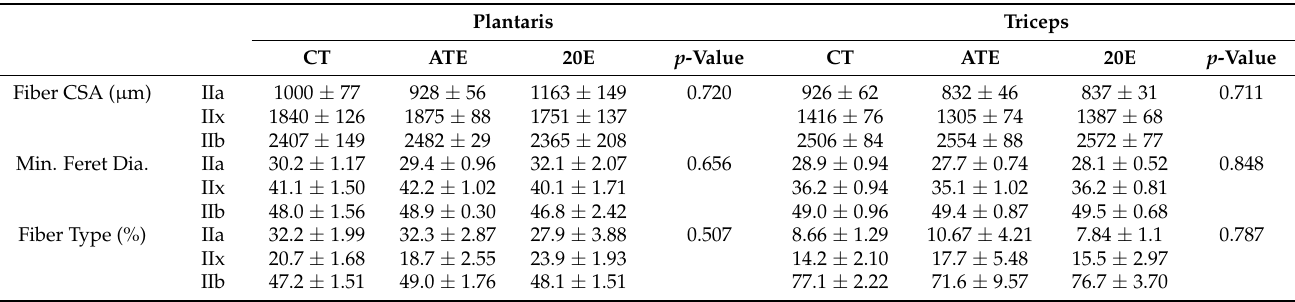
Figure 1. Immunohistochemical analysis of muscle fiber type. Representative images of fiber type and laminin staining on entire plantaris and triceps brachii cross-sections. Blue, type IIa; unstained/black, type IIx; green, type IIb; red, laminin. Scale bar = 200 µ m. Table 4. Plantaris and triceps brachii